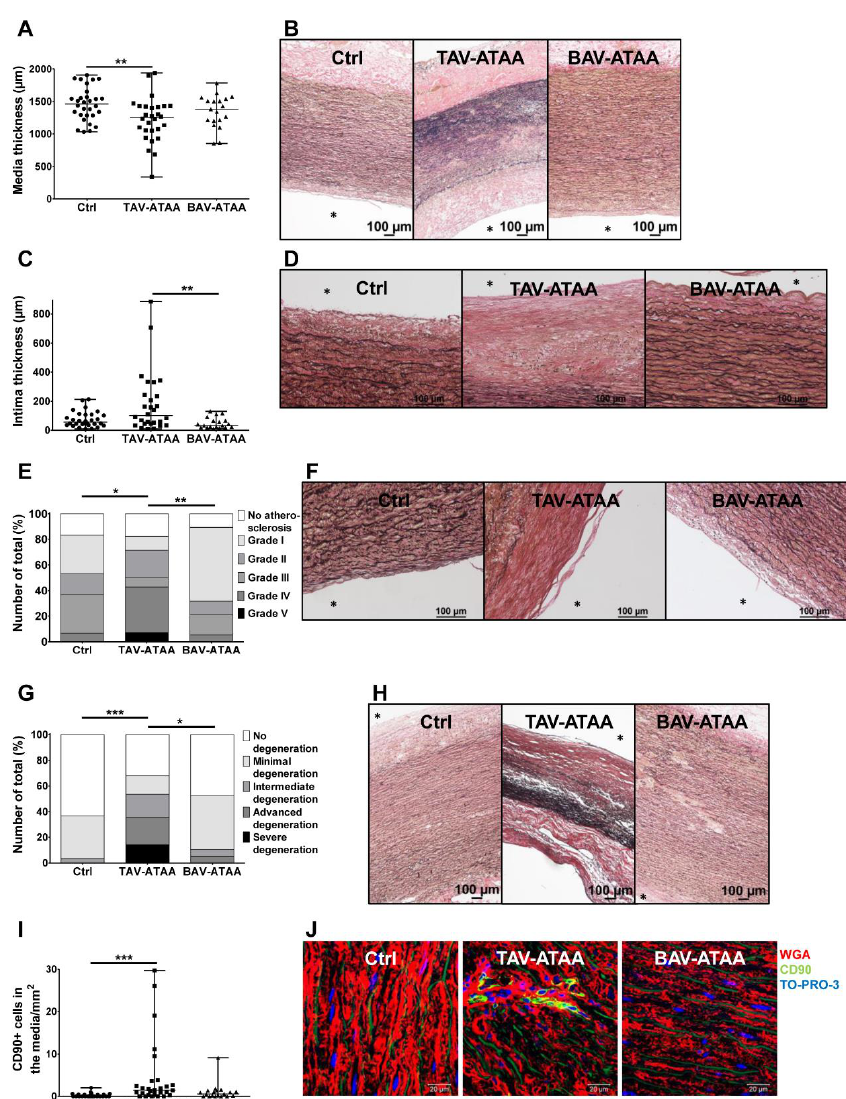
Figure 1. Changes in wall layer dimensions, atherosclerosis, media degeneration as well amount of fibroblasts / myofibroblasts in the aortic media of aneurysm patients and the control group. ( A ) shows individual sample values (and median / range) of media thickness of the three study groups. ( B ) shows representative images of EVG stained tissue sections for the quantification of media thickness (magnification 10 × , assembled images). ( C ) shows individual sample values (and median / range) of intima thickness of the three study groups. In ( D ) representative images of EVG stained tissue (magnification 20 × ) for intima thickness measurements are shown. In ( E ) the extent of atherosclerosis in the aortic wall of study groups, determined by an adopted AHA grading, is shown. ( F ) shows representative images of EVG stained tissue used for the determination of atherosclerosis severity degrees (magnification 20 × ). In ( G ) the quantification of media degeneration extent, determined by a detailed grading system, is shown. Representative EVG stained aortic tissue sections used for media degeneration grading are depicted in ( H ) (image magnification 10 × , assembled images). In ( I ) the quantification of the amount of CD90 positive cells within the aortic media is shown. ( J ) depicts representative images (magnification 63 × ) for anti-CD90 antibody staining (green), cell membrane staining with WGA (red) and cell nuclei staining with TO-PRO-3 (blue). (Control n = 30; TAV n = 28; BAV n = 19) (* < 0.05, ** < 0.01, *** < 0.001). The asterisk (*) marks the luminal side of the